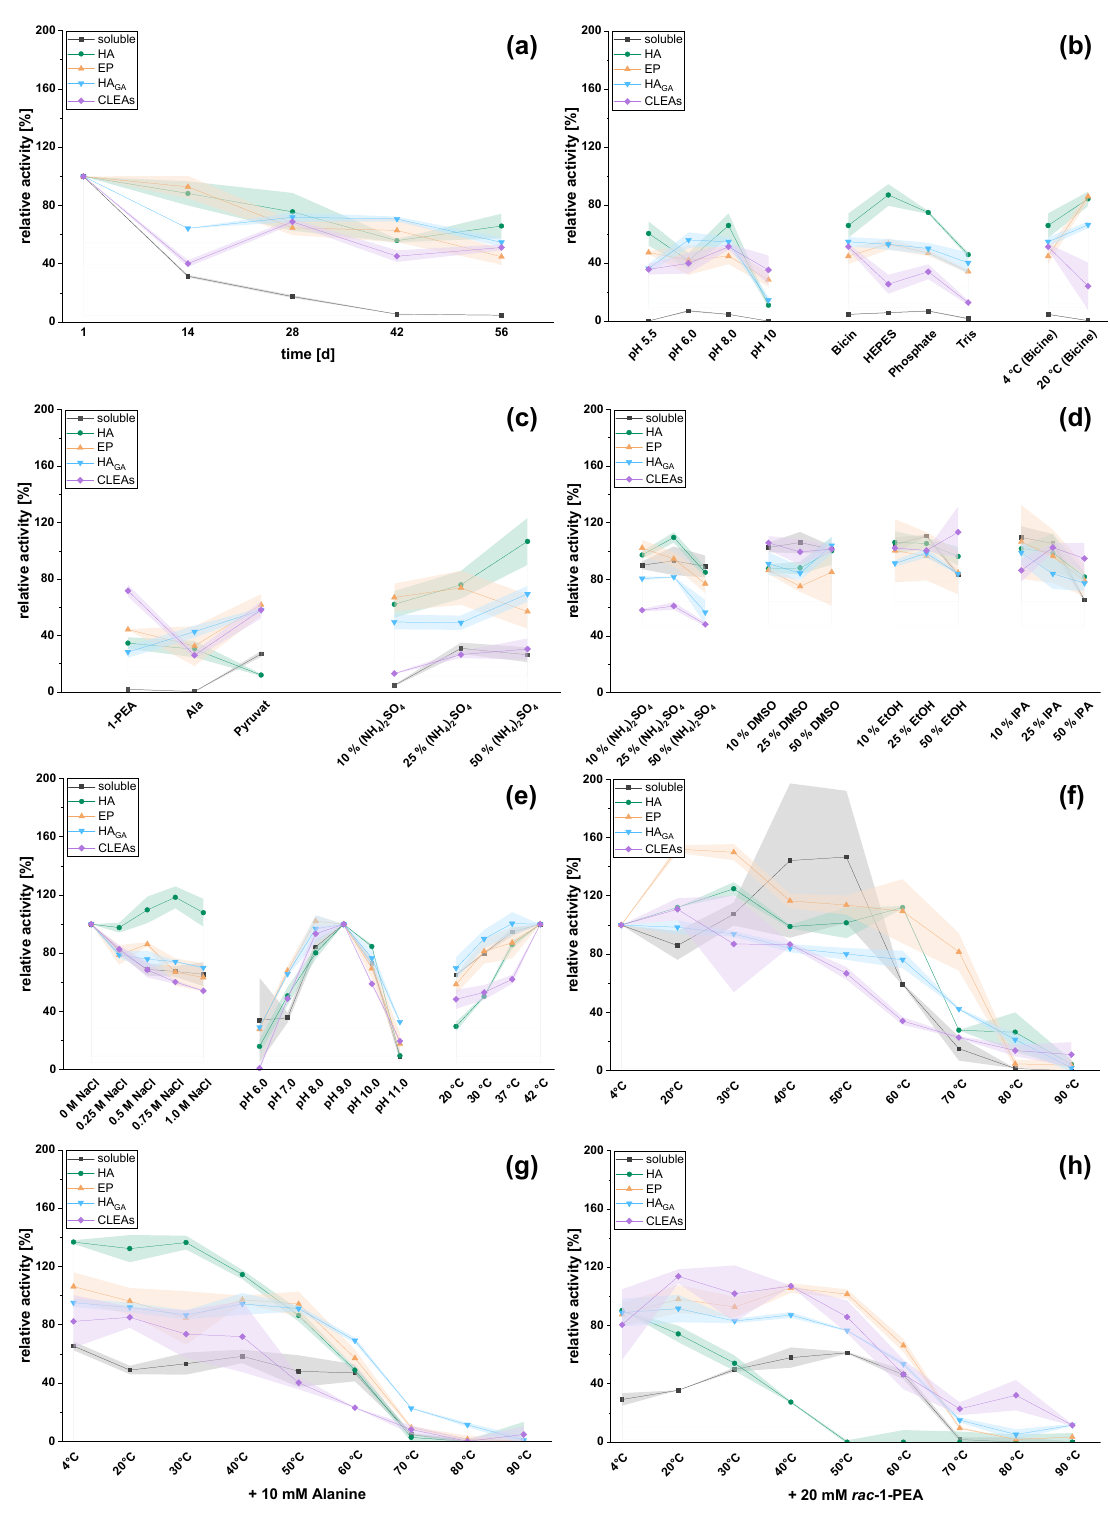
Figure 1. Stability and reactivity of ATA-Bmu under different conditions. Stabilities and activities of soluble ATA-Bmu (black) and immobilized ATA-Bmu (on HA-beads (green), EP-beads (yellow), HA GA -beads (blue) or as CLEAs (purple)) were analyzed under different conditions: ( a ) storage stability under standard storage conditions (pH 8.0, bicine buffer, 0.1 mM PLP, 4 ◦ C, dark, and exposed to air), ( b , c ) storage stability over 56 days under various conditions (different pH, buffer, and additives) while the standard storage conditions (see before) were fixed except for the varied condition, ( d ) resting solvent stability after storage at room temperature for 6 h with different additives, ( e ) reactivity at different salt concentrations, pH, and temperatures, while the standard reaction condi- tions (see below) were fixed except for the varied condition, and ( f – h ) thermostability: incubation